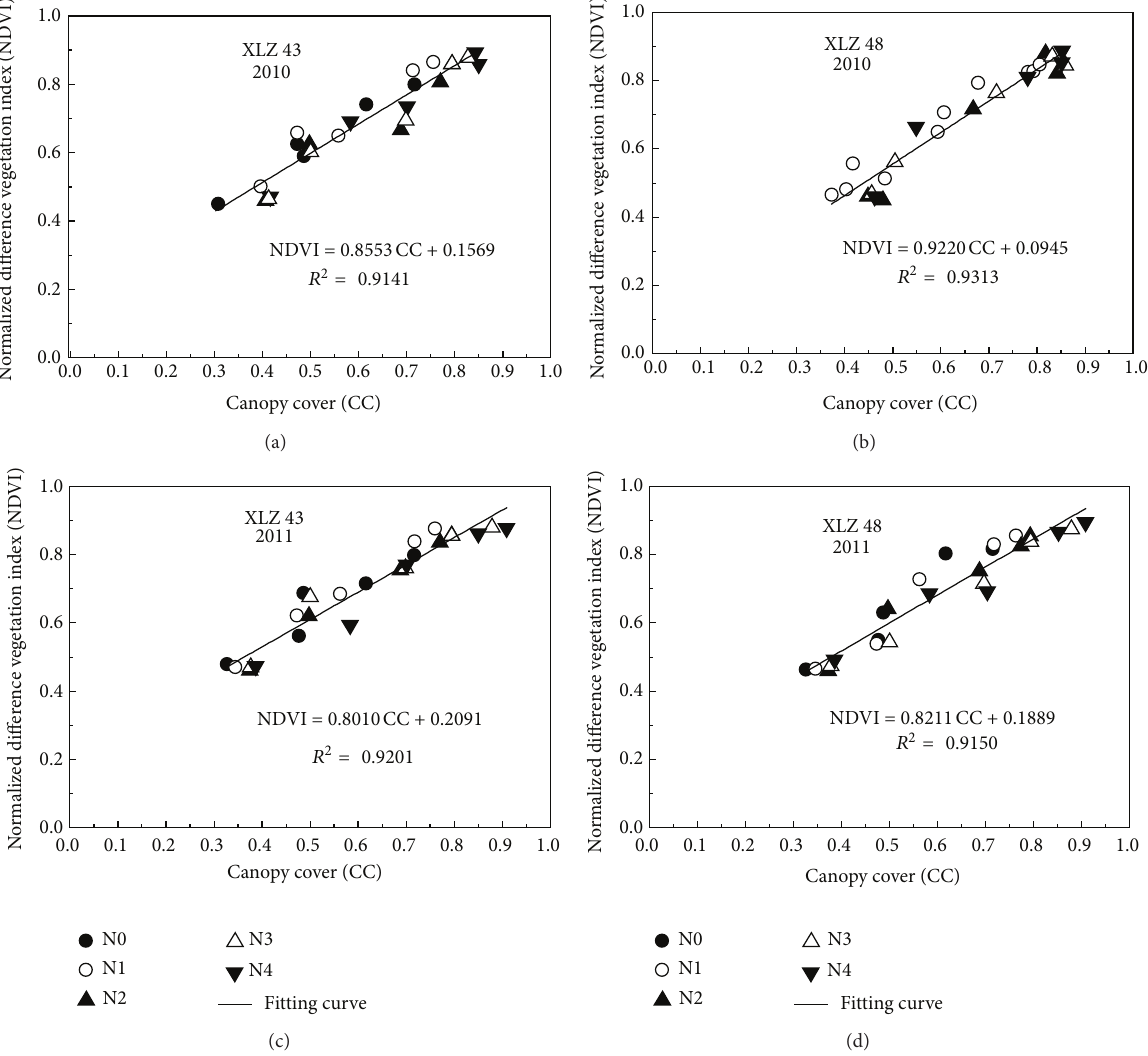
Figure 3: Results from experiment 1 showing the relationship between canopy cover calculated from digital images and normalized difference vegetation index (NDVI) estimated using a GreenSeeker handheld sensor. (a) Cotton cultivar “XLZ 43” in 2010; (b) cotton cultivar “XLZ 48” in 2010; (c) cotton cultivar “XLZ 43” in 2011; (d) cotton cultivar “XLZ 48” in 2011.